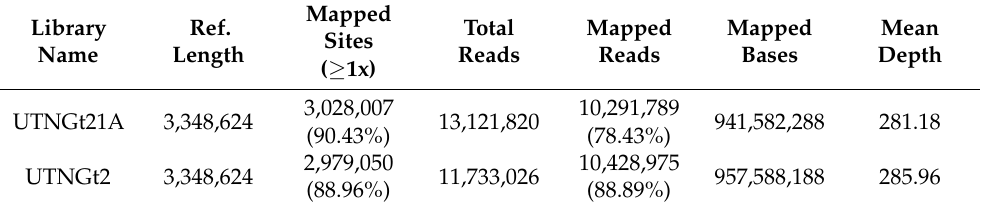
Table 1. Mapping data